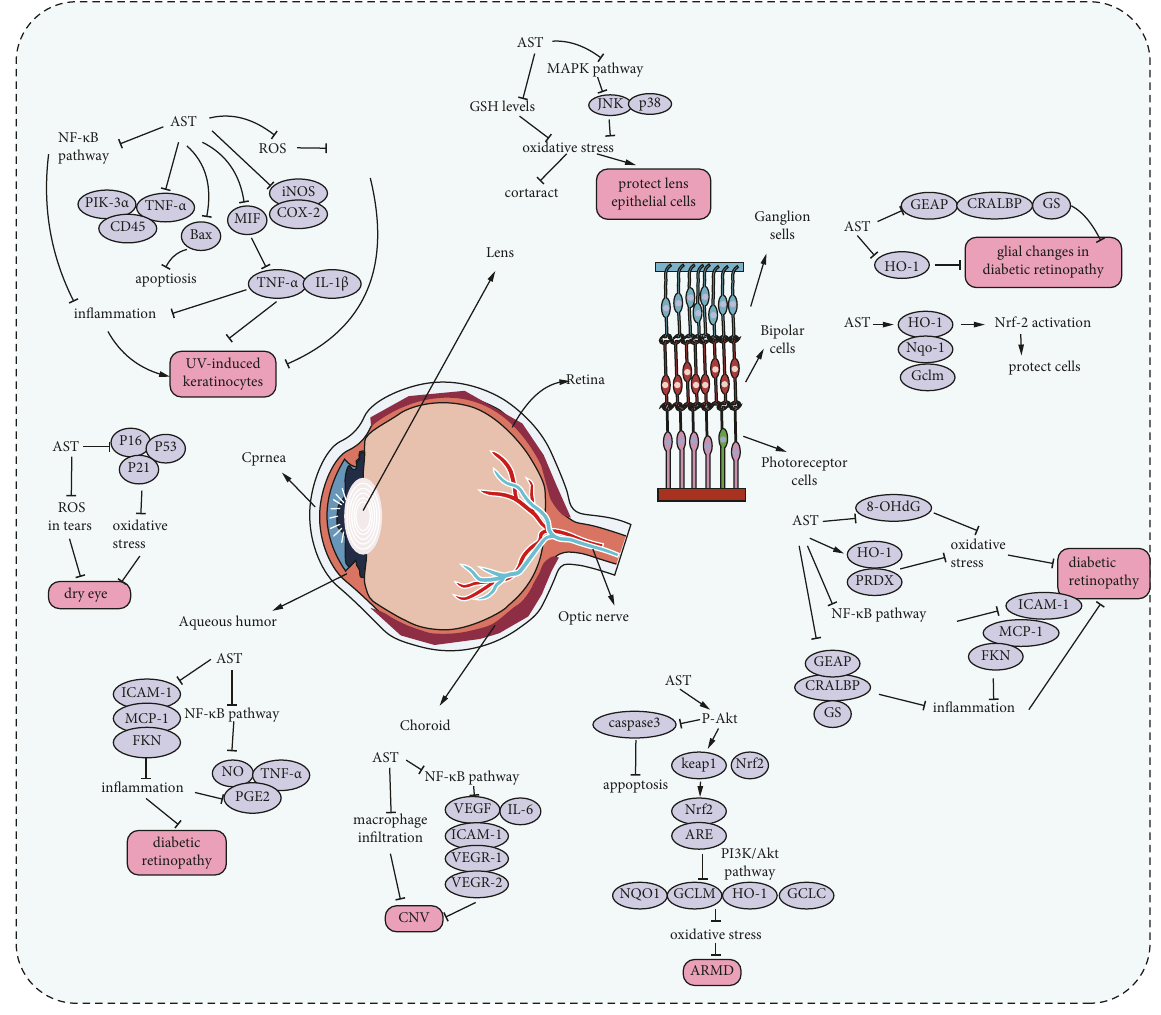
Figure 1: An illustration of AST targets in the ocular